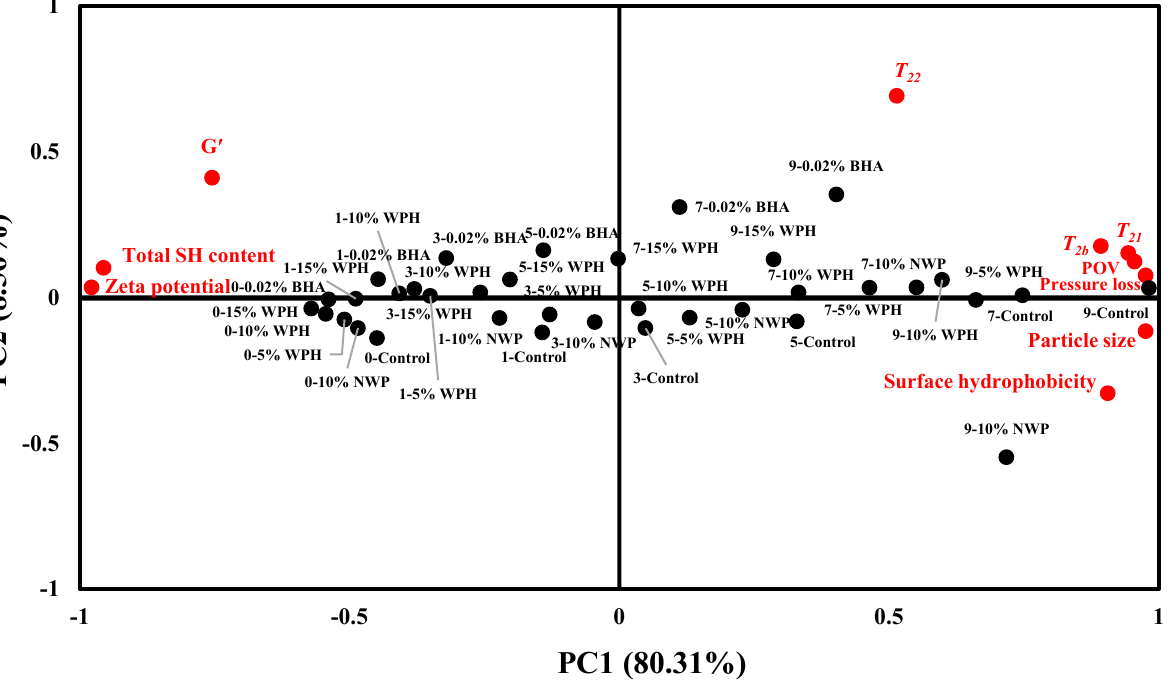
Figure 9. Principal component analysis (PCA) of the oxidative reaction, protein structure and water-holding of multiple freeze–thaw (F–T) cycles of pork patties. PC1: the first principal component; PC2: the second principal component; control: without any additives in the sample; NWP: native whey protein; BHA: butylated hydroxyanisole. T 2b : bound water; T 21 : immobilized water; T 22 : free water; G ′: storage modulus; POV: peroxide value; total SH content: total sulfhydryl content.